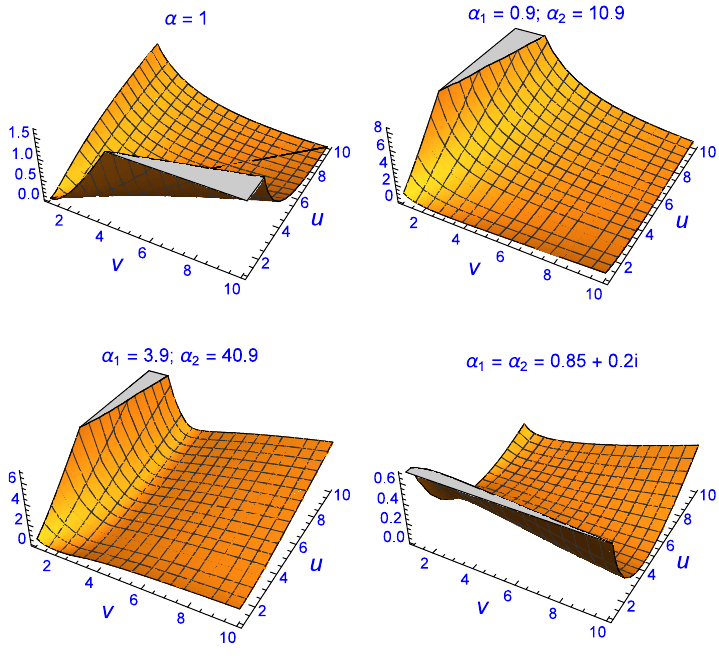
Figure 4. Further manipulation of the (fractional) divergence manifold between two Exponential-densities via the fractional orders α 1 and α 2